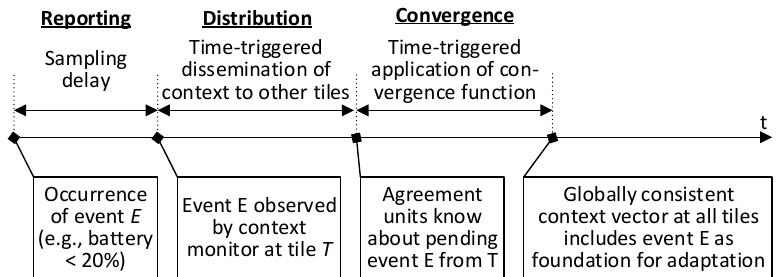
Figure 6. Timeline of agreement for an example context